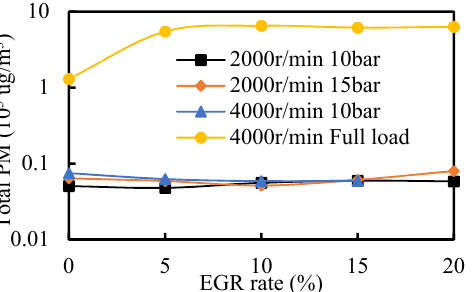
Figure 11. The effect of EGR rate on the mass concentration of particulate matter.